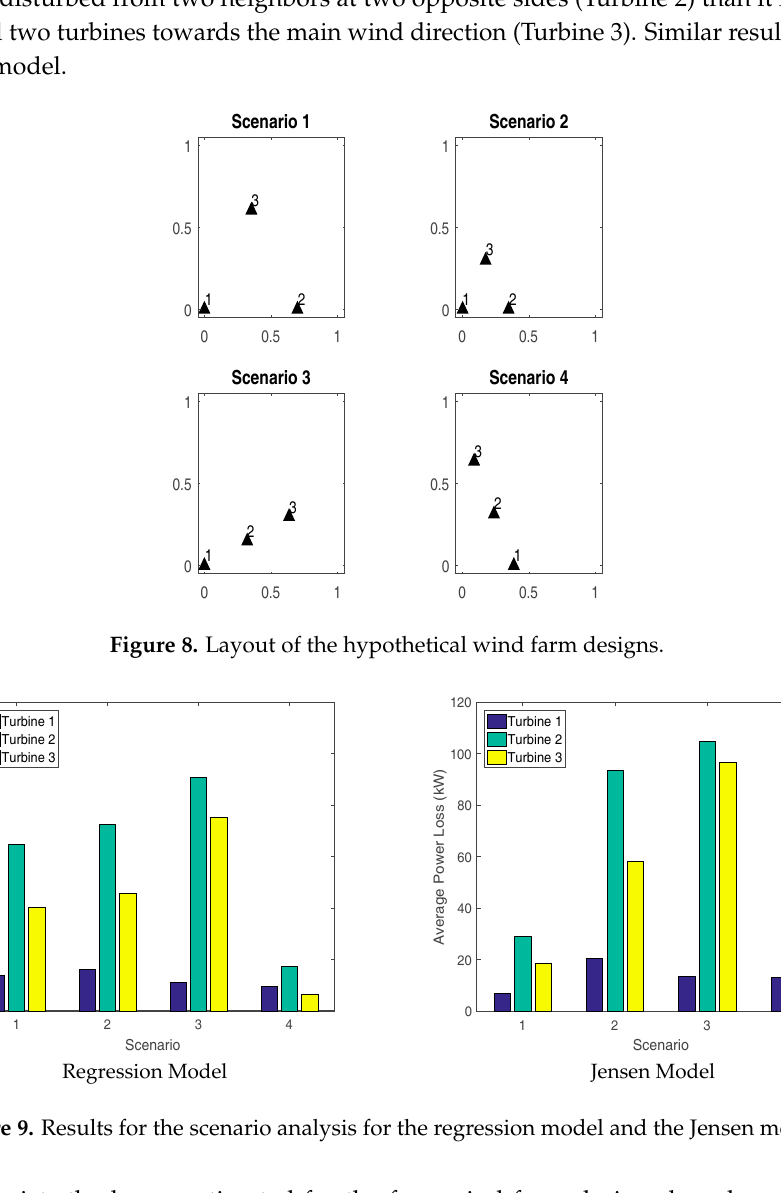
Jensen Model Figure 9. Results for the scenario analysis for the regression model ( left ) and the Jensen model ( right ). Table 6 depicts the losses estimated for the four wind farm designs based on the regression model. The first part shows the average 10 min losses per observation, as in the left part of Figure 9.